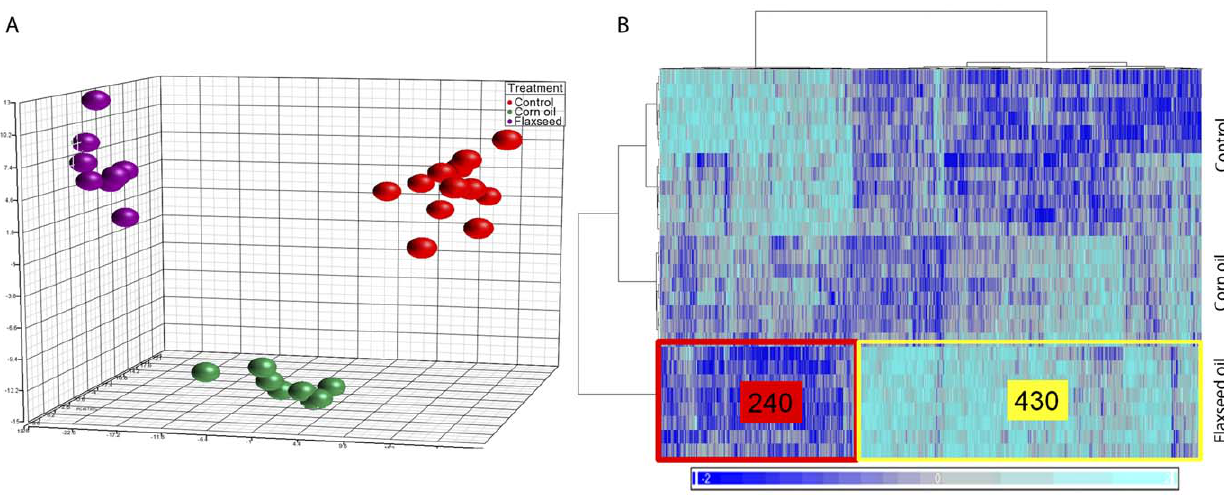
Figure 3. Gene expression changes in the mammary gland. Test diets were given from two weeks prior to conception to 6 weeks of age, and regular diet thereafter. Microarray analysis was performed at 10 weeks of age. After removing litter-size and batch effects the source of variance was plotted for regular diet (red; n =12), high-fat diet based on corn oil (green, n =8) and high-fat diet based on flaxseed oil (magenta, n =8) using PCA. The heat-map shows clustering of 670 differentially-regulated genes (horizontal) and samples (vertical).